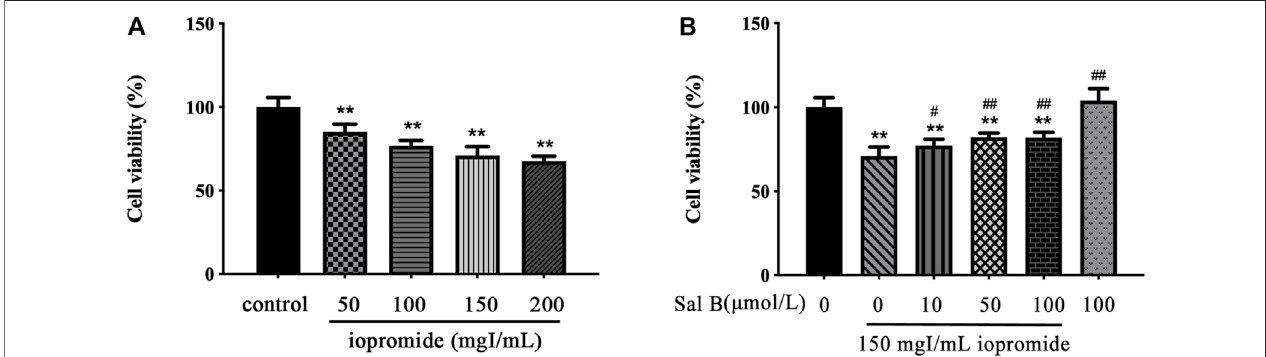
FIGURE1| EffectofiopromideandSalBoncellviabilityinHK-2cells. (A) Differentdosesofiopromidewerefoundtocauseasigni fi cantdecreaseincellviability. (B) Different doses of Sal B protected HK-2 cells against iopromide-induced injury. The data were determined by ANOVA and LSD post-hoc test and are presented as the